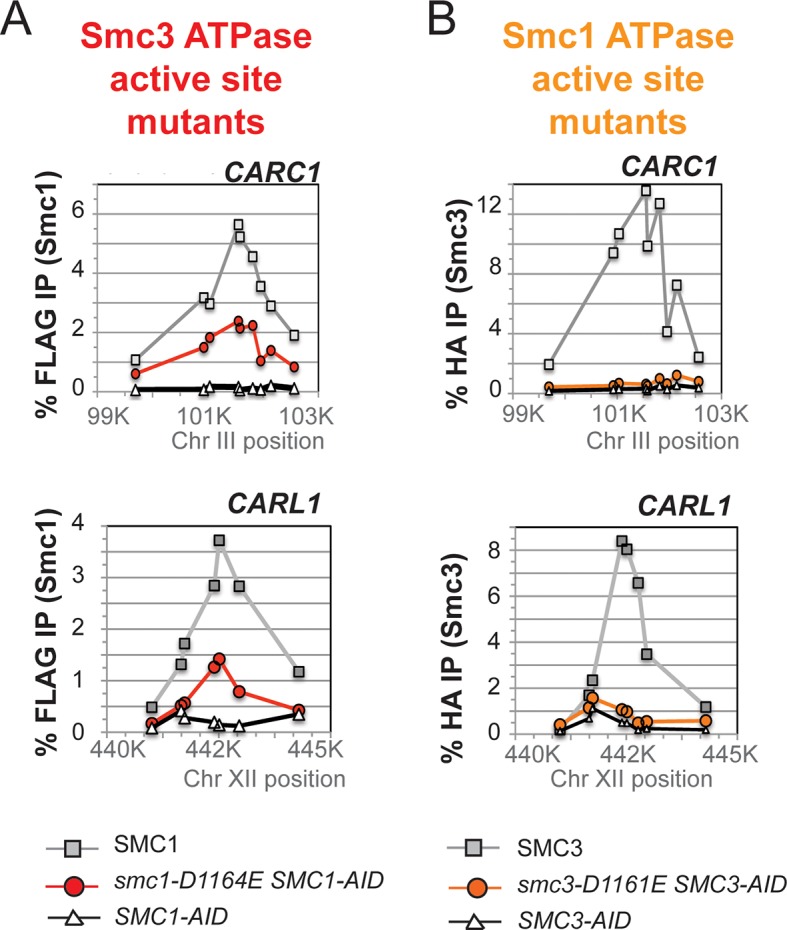
Chromosomal binding of cohesin in smc1-D1164E and smc3-D1161E mutants assayed by antibodies against tagged Smc1 and Smc3 subunits.(A) ChIP of 3Flag tagged Smc1 in M phase cells depleted for Smc1-AID. Cells from Figure 5A were processed for ChIP using anti-FLAG antibodies and% Flag tagged Smc1 binding plotted as described for Mcd1 in Suppl. Figure 2F. ChIP of Smc13FLAG and smc1-D1164E3FLAG at chr. III centromere-proximal CARC1 (top panel) and chr. XII centromere-distal CARL1 (bottom panel). Smc13FLAG Smc1AID (SMC1; light grey line, open squares), Smc1-D1164E3FLAG Smc1AID (smc1-D1164E SMC1-AID; dark grey line, grey circles), and Smc1AID alone (SMC1-AID; black line, open triangles). (B) ChIP of 6HA tagged Smc3 in M phase cells depleted for Smc3-AID. Cells from Figure 5B were processed for ChIP using anti-HA antibodies and% HA tagged Smc3 binding plotted as described for Mcd1 in Figure 3—figure supplement 4. ChIP of Smc36HA and smc3-D1161E6HA at chr. III centromere-proximal CARC1 (top panel) and chr. XII centromere-distal CARL1 (bottom panel). Smc36HA Smc3AID (SMC3; light grey line, open squares), Smc3-D1161E6HA Smc3AID (smc3-D1161E SMC3-AID; dark grey line, grey circles), and Smc3AID alone (SMC3-AID; black line, open triangles).